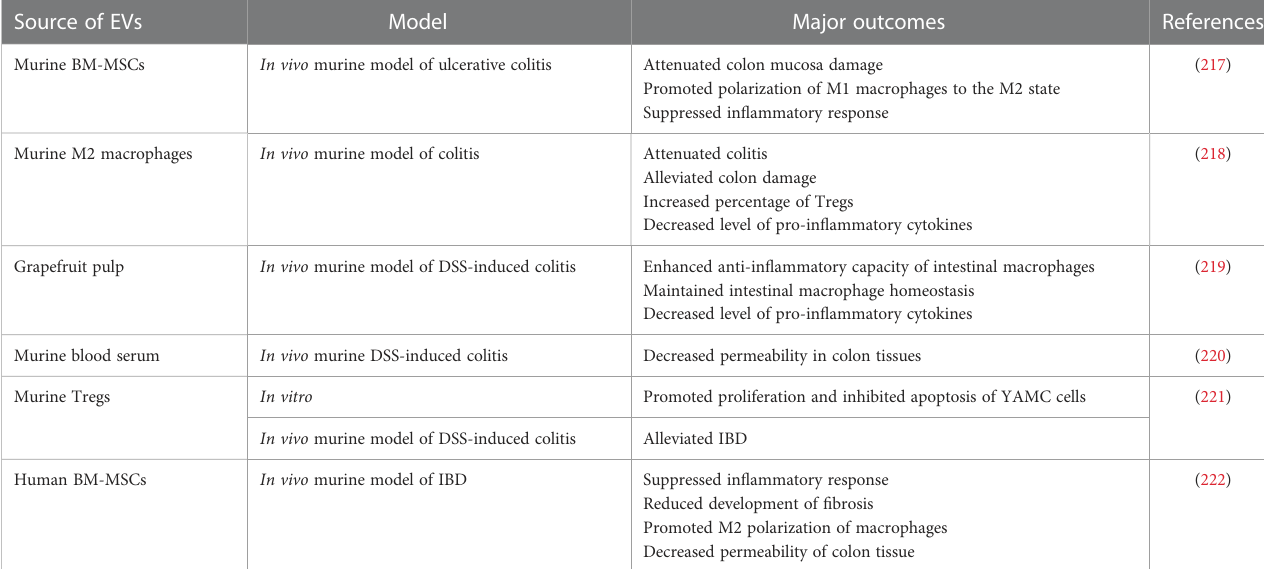
TABLE 6 Examples of EV use in preclinical studies related to the treatment of the digestive system disorders. Source of